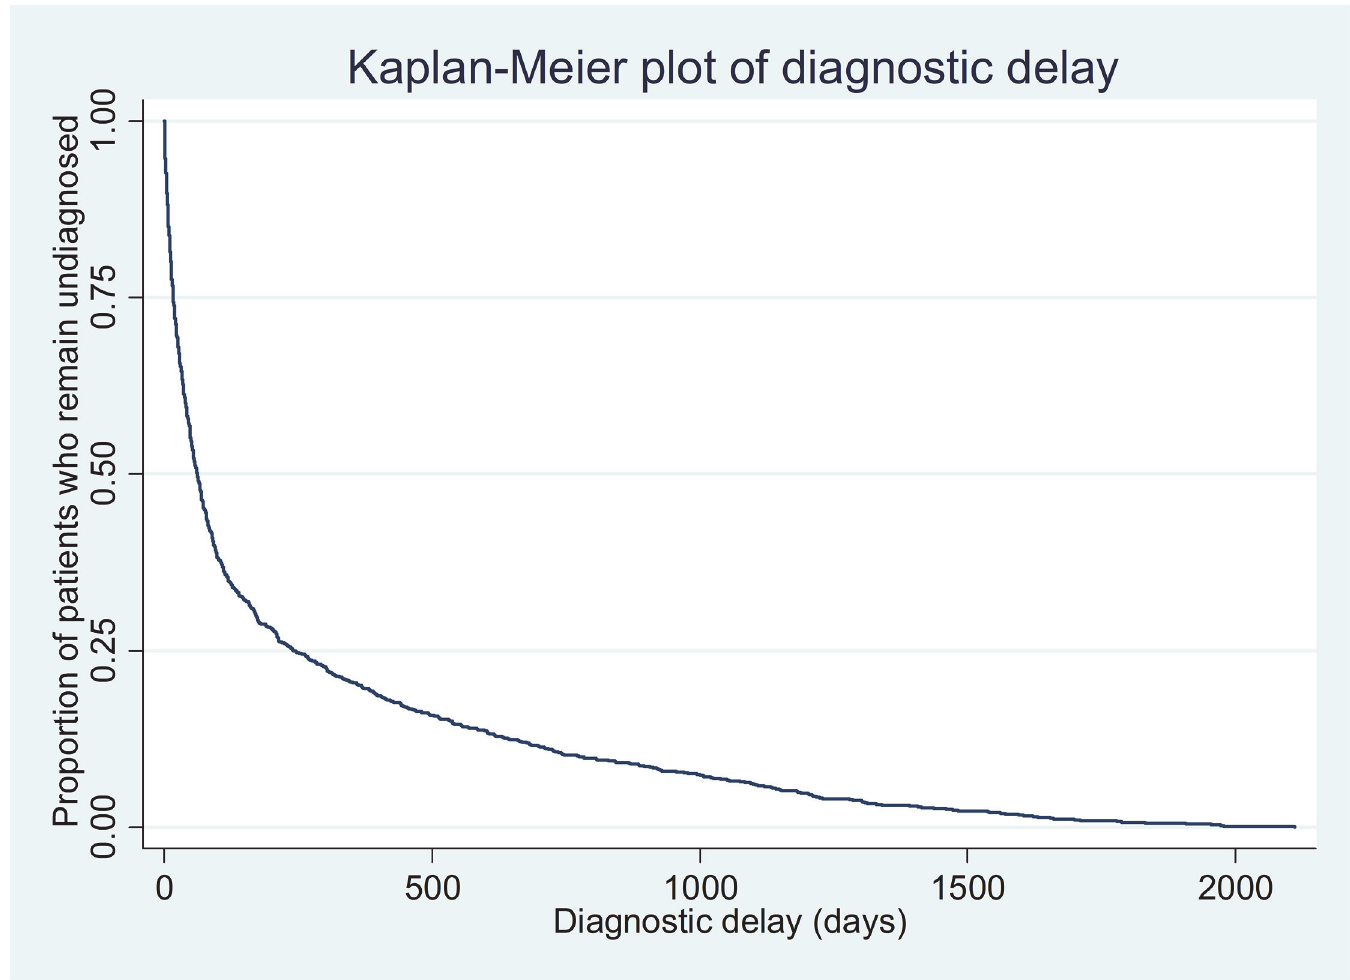
Fig 1. Kaplan-Meier plot of diagnostic